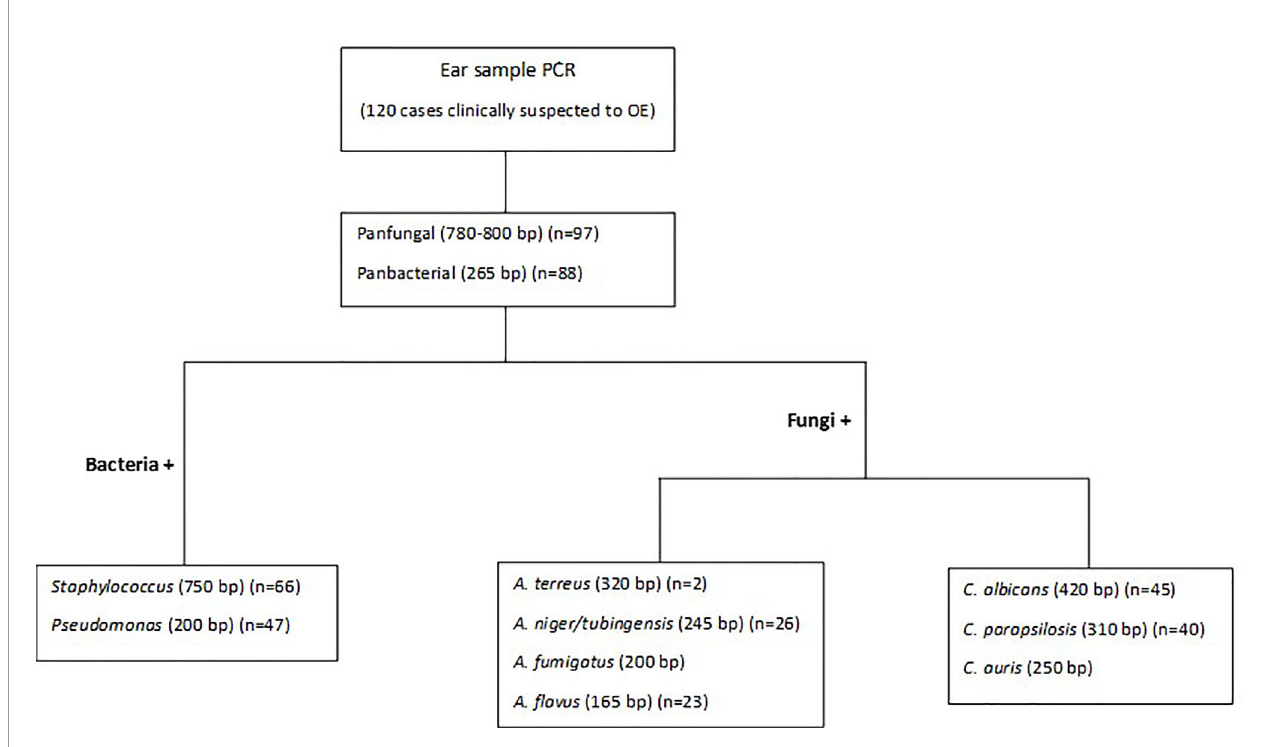
FIGURE 1 | Schematic of the stepwise multiplex PCR.